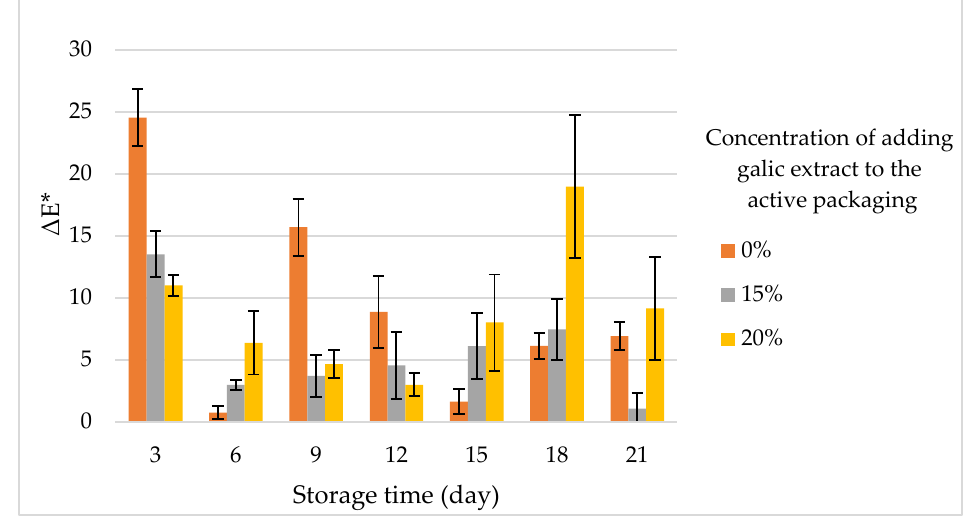
Figure 4. Total color difference ( Δ E ∗ ).